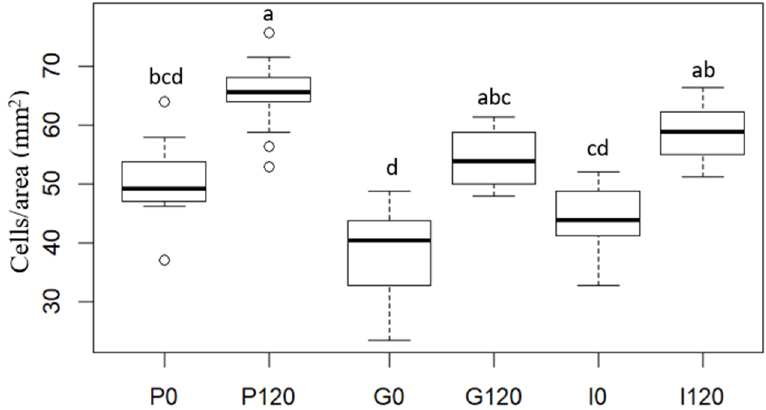
Figure 5. Cell number per unit of tissue surface (cells/area (mm 2 )) of red bell pepper samples: raw (P0), treated 120 min with HPU (P120), and these samples after in vitro gastric (G) and intestinal (I) digestions. Different letters for the same parameter indicate significant differences ( p < 0.05) among samples